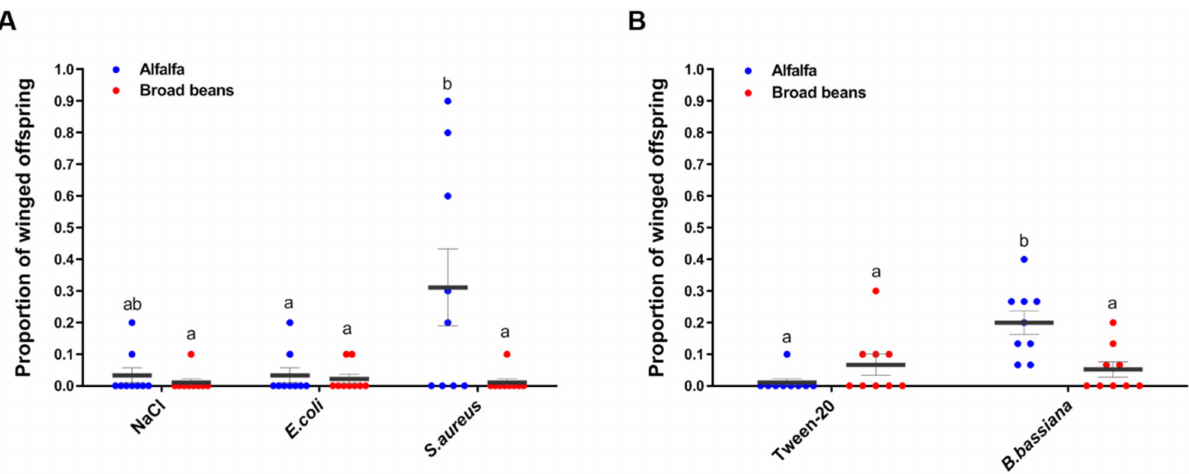
Figure 2. The proportion of winged offspring produced by adult pea aphids after bacterial and fungal infections. The adult aphids were challenged with bacteria ( A ) and fungal spores ( B ) ( n = 9). Each dot represents winged offspring from an individual aphid. The bars show the mean values ± SEM. Different letters indicate p <